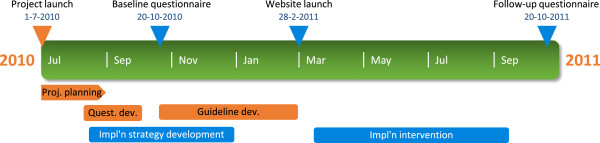
Project timeline. Guideline development, guideline implementation strategy development, guideline implementation intervention, and evaluation time points. Blue elements are part of this study.